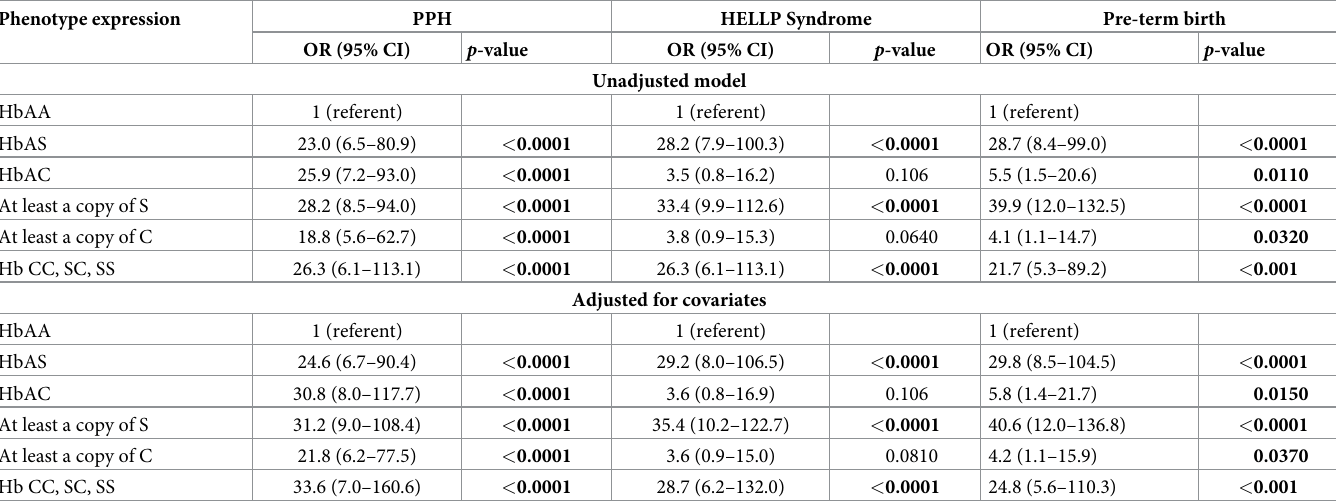
Table 5. Association between haemoglobin variants and foeto-maternal outcomes among the study